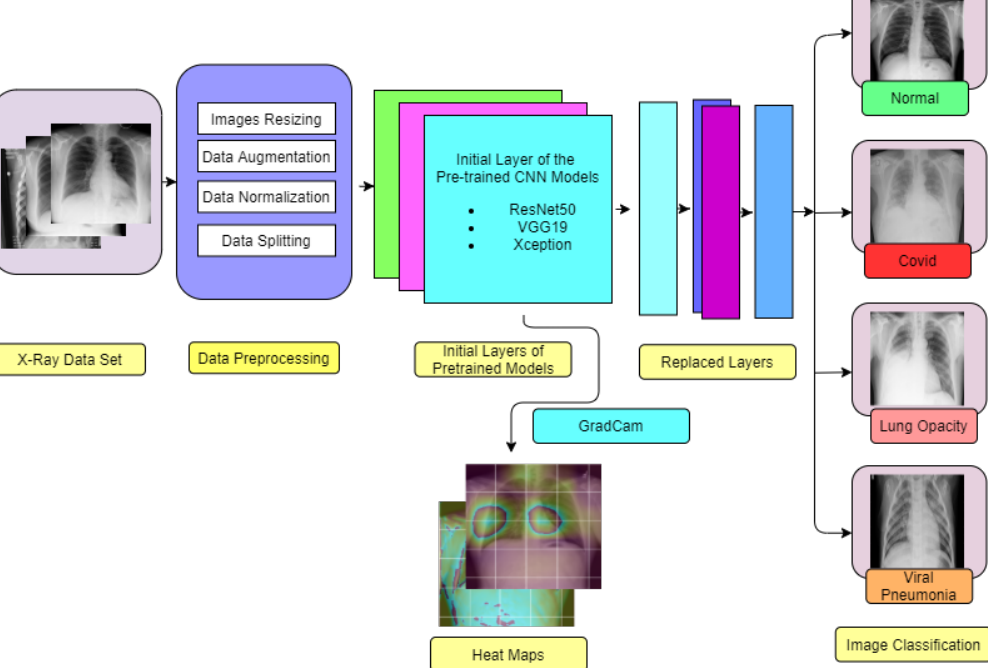
Figure 3. Complete Block Diagram of Experiments. For two class classification only normal and COVID image is detected whereas for multi class problem Normal, COVID, Lung Opacity and non-COVID viral pneumonia is